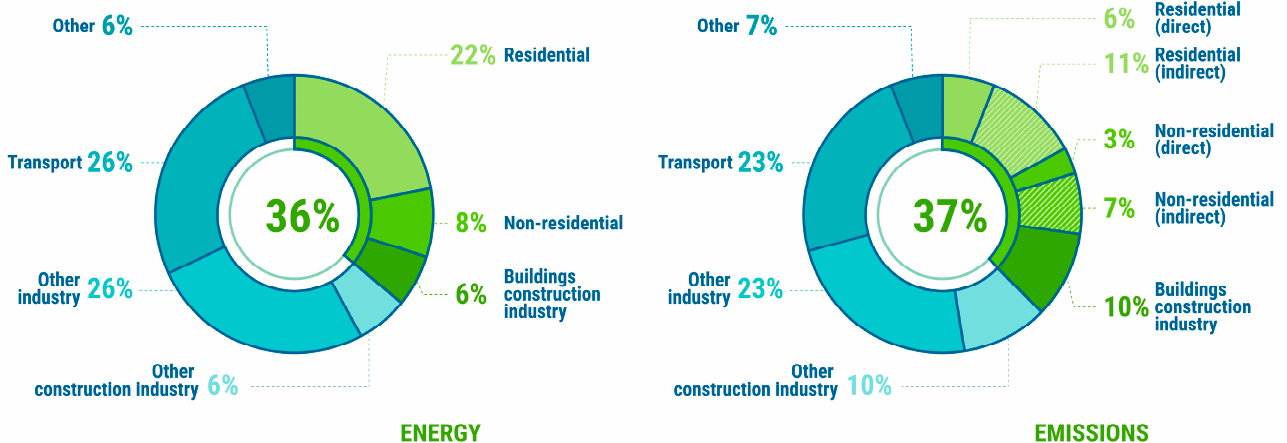
Figure 1. Buildings and construction’s share of global energy and energy-related CO 2 emissions in 2020 [1].